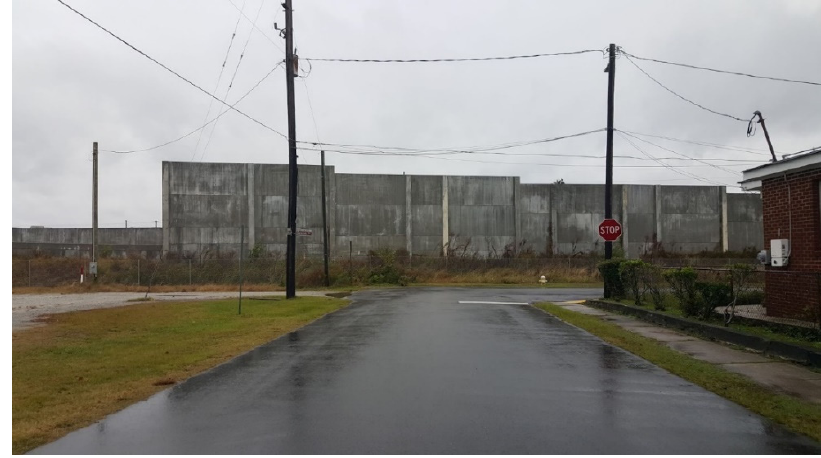
Figure 12. A portion of SCDOT’s sound wall in Rosemont, photograph taken by Judy Taylor on Peace Street.